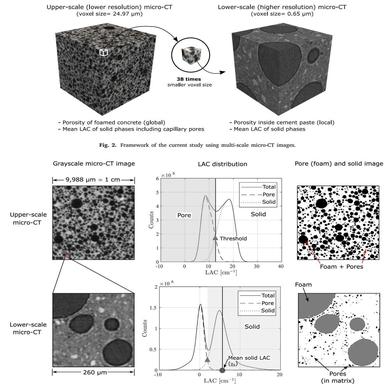
Segmentation of pore, foam, and solid phases from grayscale micro-CT images using thresholding method.